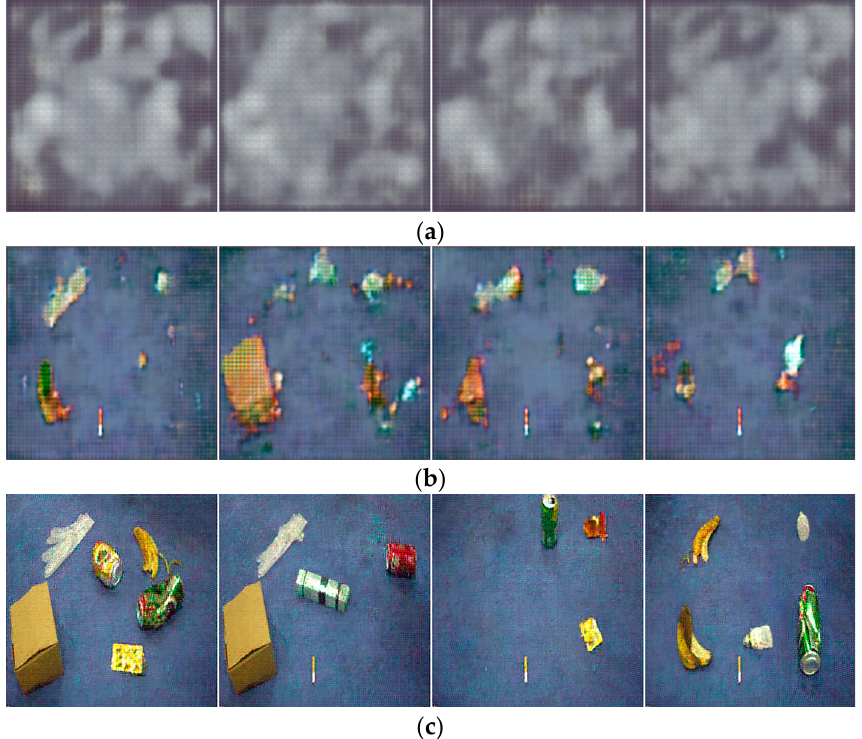
Figure 10. The e ff ect of improved DCGAN for generating multi-target waste images under di ff erent iterations: ( a ) Epoch10; ( b ) Epoch100; and ( c ) Epoch200. iterations: ( a ) Epoch10; ( b ) Epoch100; and ( c )